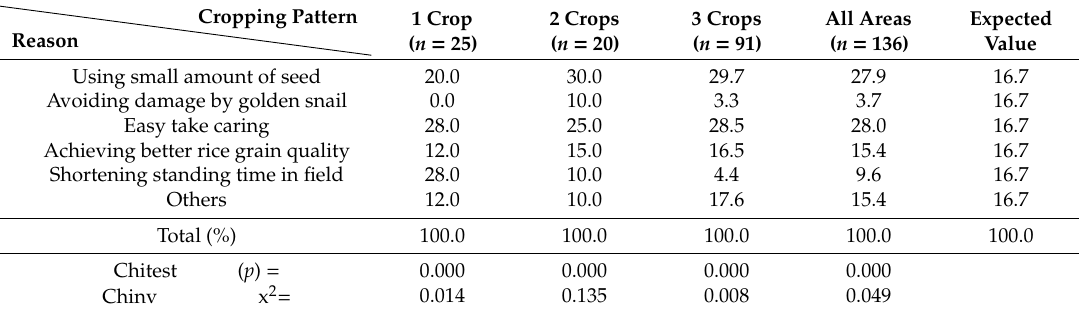
Table 9. Reason for shifting from row sowing to transplanting machine (%). Cropping Reason